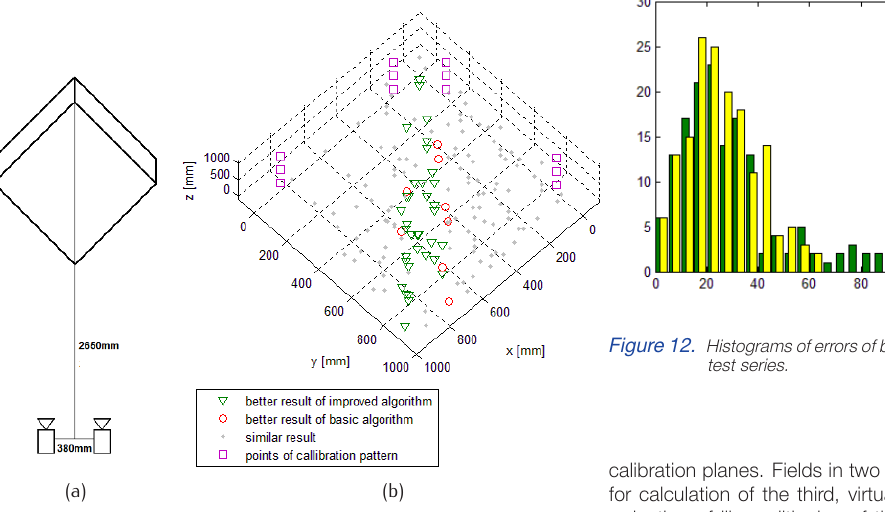
Figure 11. a) Scheme of cameras setup in chosen test series. b) Reconstruc- tion of the scene with marked all test point for chosen test series. Points with error difference between basic and improved algorithm bigger than 10 mm are marked as triangles or circles (differences below 10 mm are presented as similar in order to keep the picture clear).